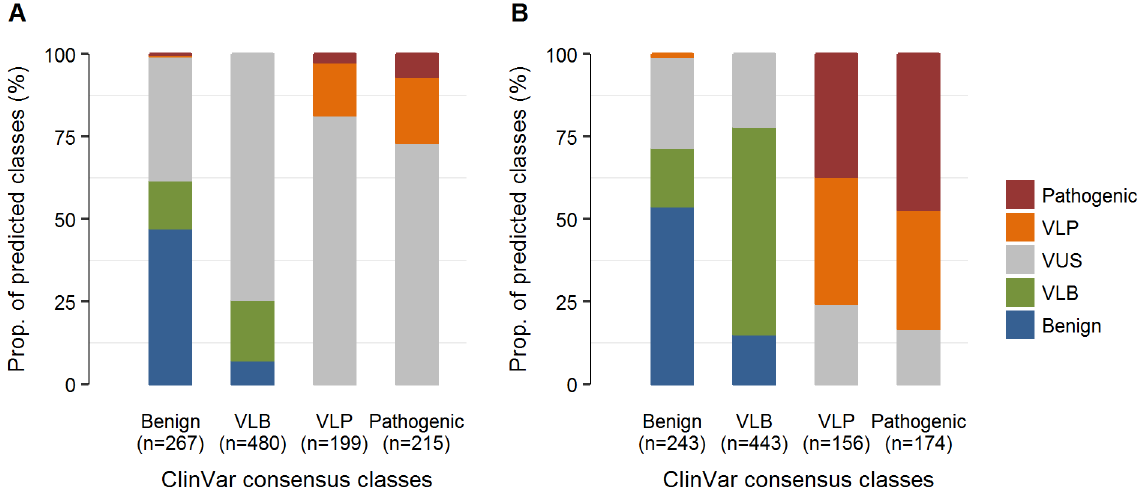
Fig 2. Outcome of 5-tiered predicted classes in MGPT data. ( A ) The proportions of predicted classes from gene-specific IVP model analysis in which each prediction was evaluated from a subset of 16 in silico predictors. The analysis was based on 1,161 class known missense variants in 10 genes using LOOCV. ( B ) The proportions of predicted classes from MVP model analysis in which each prediction aggregated a prior distribution from IVP model with the available evidence predictors. The analysis was based on 1,016 variants with any available evidence